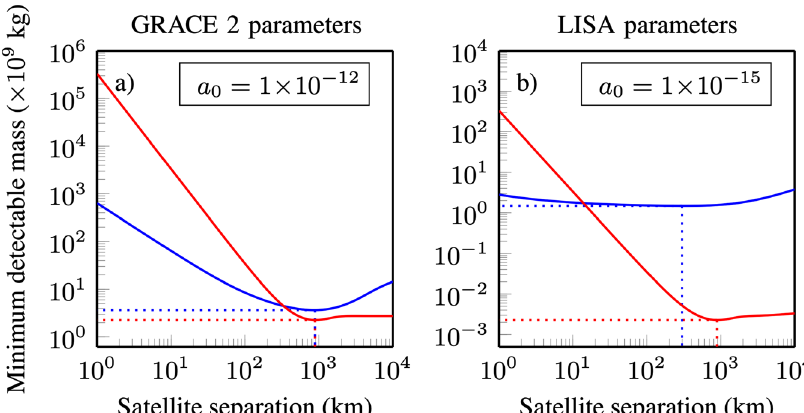
Fig. 5 Optimal satellite separation for point mass sensitivity. Shown is the point mass sensitivity both with (red lines) and without (blue lines) TDI for accelerometer noises of a 0 ¼ 1 ´ 10 (cid:3) 12 ms (cid:3) 2 Laser thermal noise is x T = 1 × 10 − 15 and satellite orbital height is h = 500 km. The optimal satellite separation is that which minimises the minimum detectable mass, and is different for different mission con fi